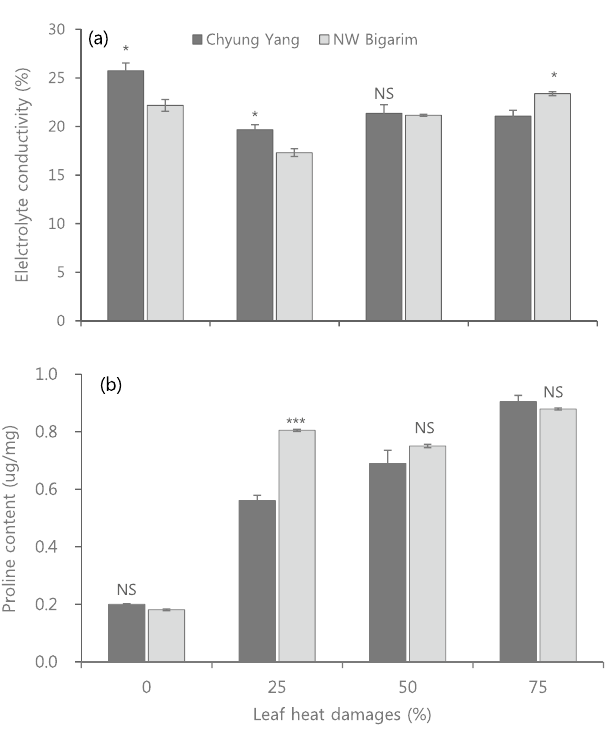
Figure 3. Effect of leaf heat damage levels on plant height ( a ), fruit set ( b ), the number of fruits ( c ) and total yield ( d ) in hot pepper cultivars. Vertical bars represent standard deviation (n = 3). Different letters indicate significant differences by Duncan’s multiple range test at p < 0.05. All parameters were measured on 70 days after transplanting.